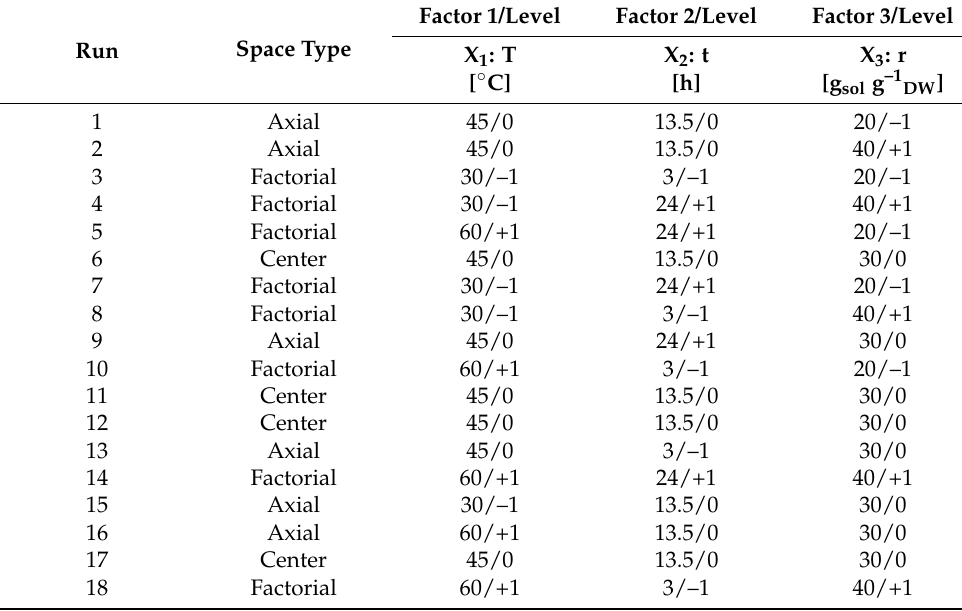
Table 8. Experimental design of three-factor, three-level CCD. Factor 1/Level Factor Run Space Type